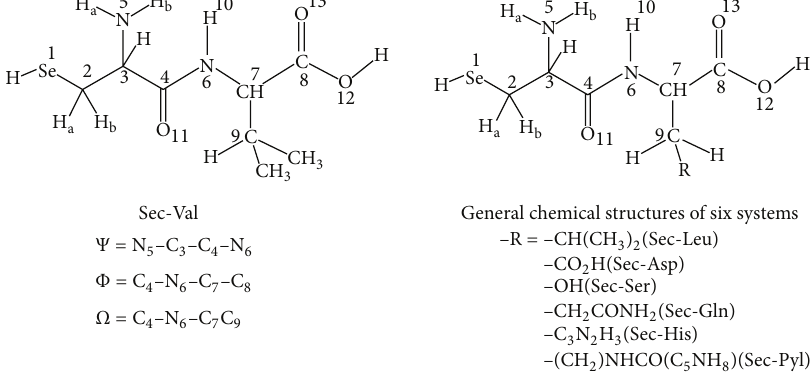
Figure 2: Schematic representation of chemical structures of the seven dipeptides studied. Table 1: Gas and aqueous phase data on total energies a (kcal/mol), rotational constants (GHZ), and dipole moments (Debye) of the dipeptides calculated using B3LYP/6-311++G(d,p) level of